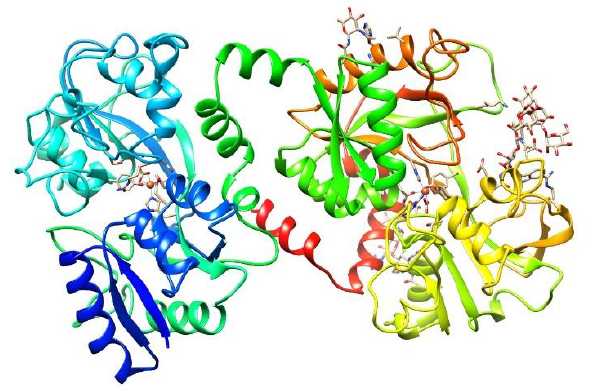
Figure 1. Structure of bovine diferric lactoferrin (holo-bLf). The three-dimensional structure of holo-bLf was determined by X-ray crystallography to investigate the factors that influence iron binding and release by transferrins. https://www.rcsb.org/structure/1BLF. Visualized with UCSF Chimera [52].